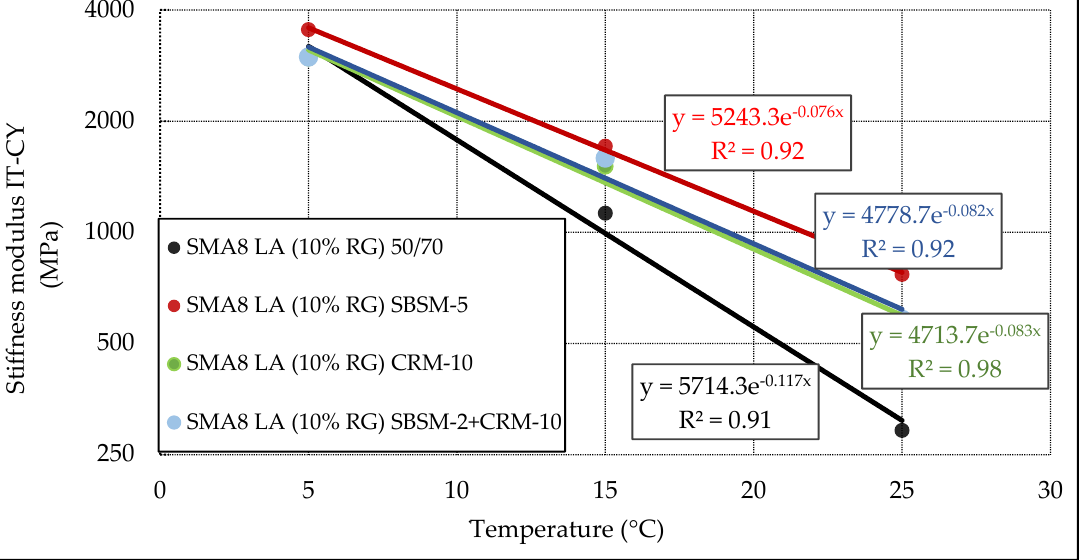
Figure 6. Sti ff ness modulus IT-CY of SMA8 LA (10% RG) mixtures as a function of temperature, Figure 6. Stiffness modulus IT-CY of SMA8 LA (10% RG) mixtures as a function of temperature, depending on the modified depending on the modified binder.